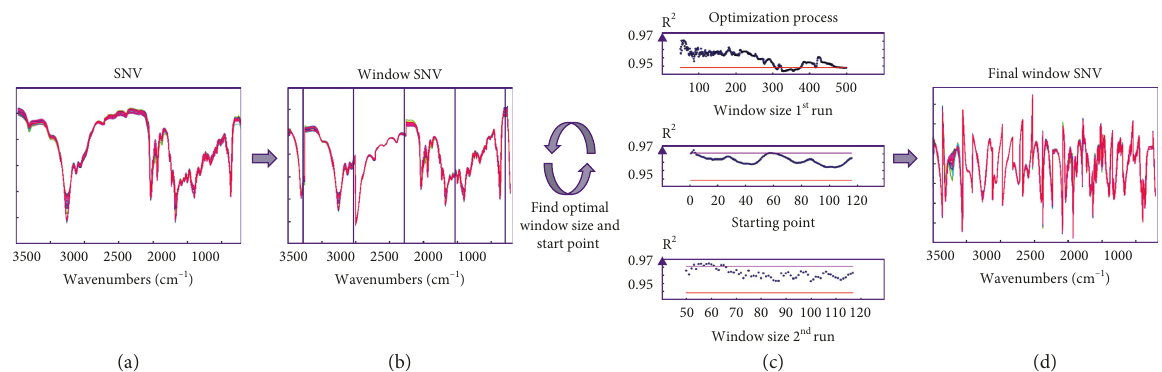
Figure 4: Demonstration of the workflow and optimization process for Dynamic Localized SNV. (a) Single SNV, (b) Dynamic Localized SNV with starting point 100 and window 300 for visualization, (c) three-stage optimization process for window, starting point and final window optimization, and (d) optimized